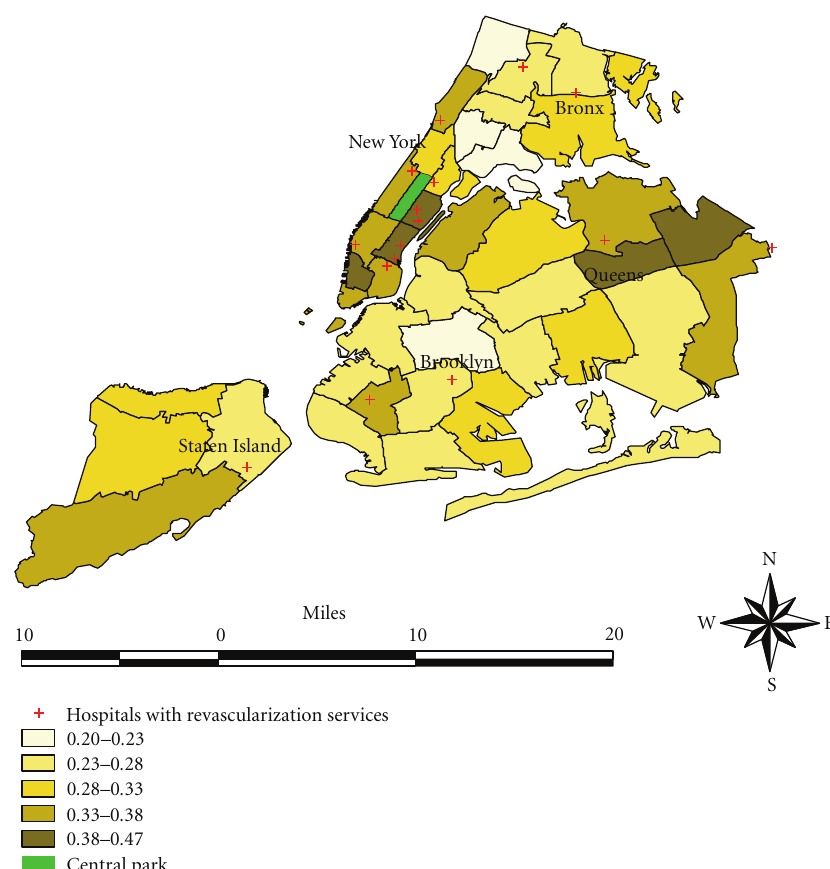
Figure 2: Adjusted rate of revascularization after AMI in NYC neighborhoods